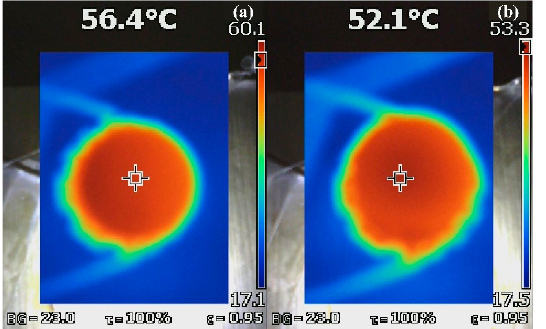
Figure 7. ( a ) Operating temperatures of hemispherical dome and ( b ) cylindrical-shaped PiGs under 10 W COB chips after 180 s.